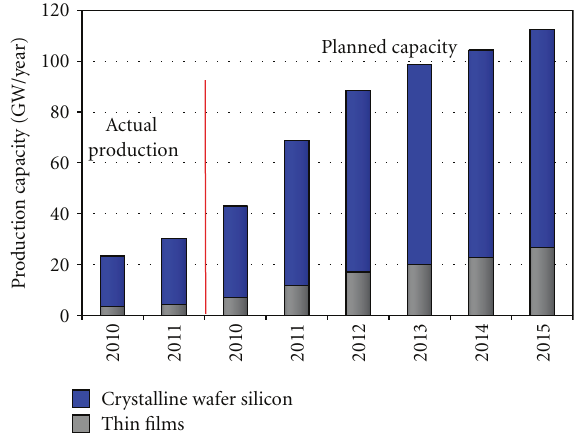
Figure 5: Actual and planned PV production capacities of thin film and crystalline silicon-based solar modules.